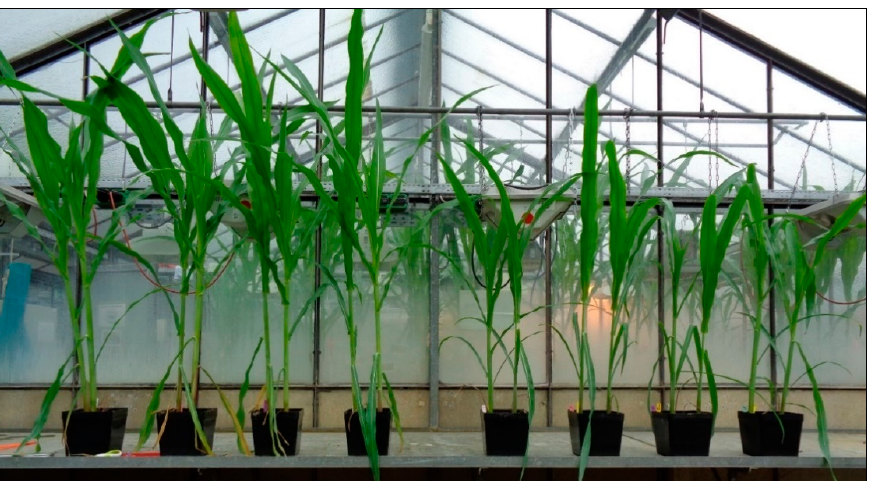
Figure 1. Untreated maize plants before harvest (47 DAS) with sufficient irrigation water ( left ) and reduced irrigation water ( right ).